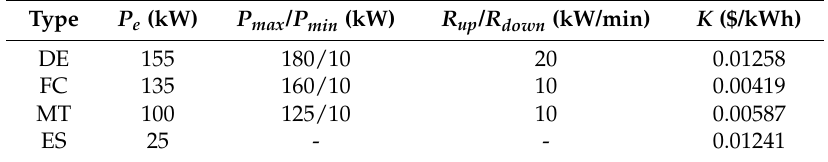
Table 2. Pollutant discharge coefficient.